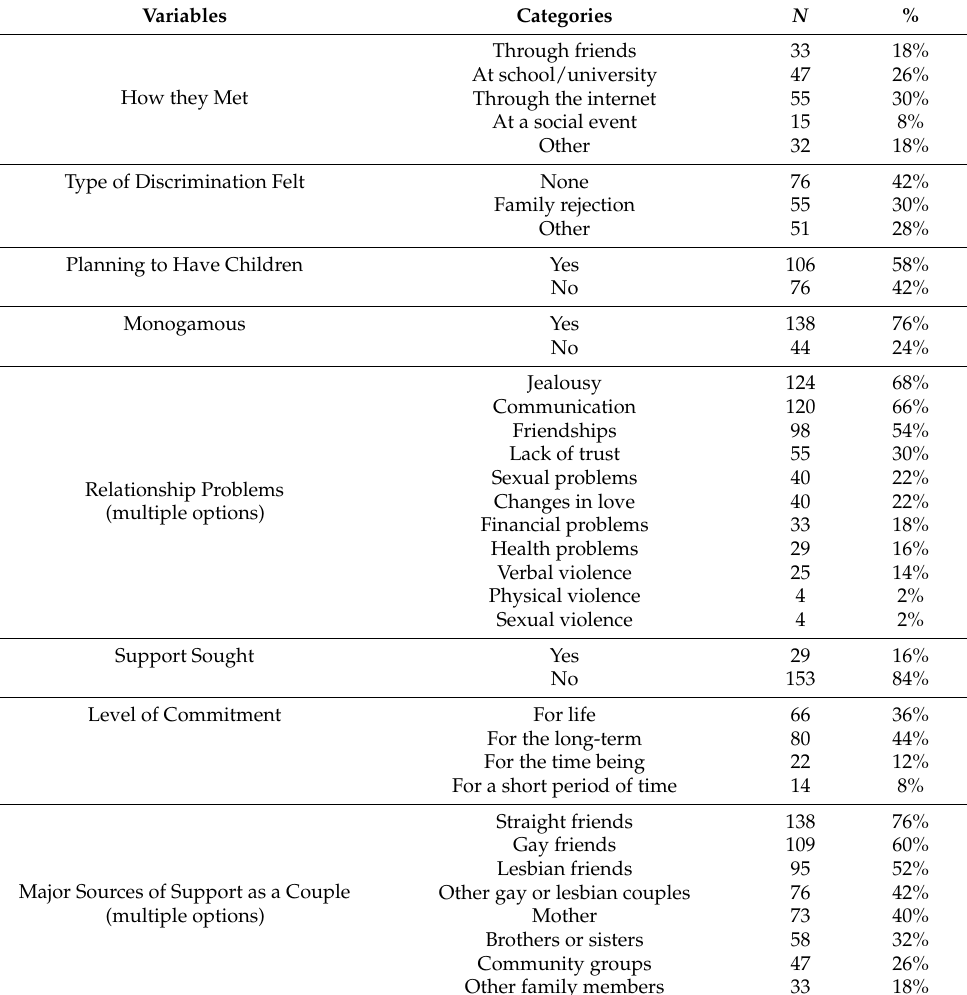
Table 2. Results for Relationship